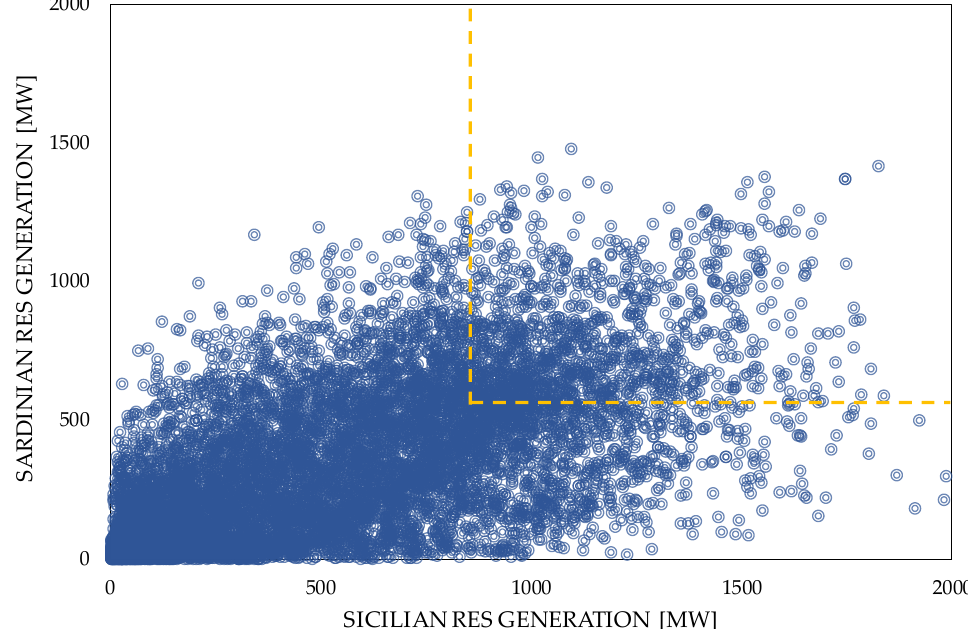
Figure 11. Correlation analysis about Sicilian and Sardinian RES production. The yellow hatch delimites the area where there was a simultaneous production greater than the third quartile of the generation curves of each region.